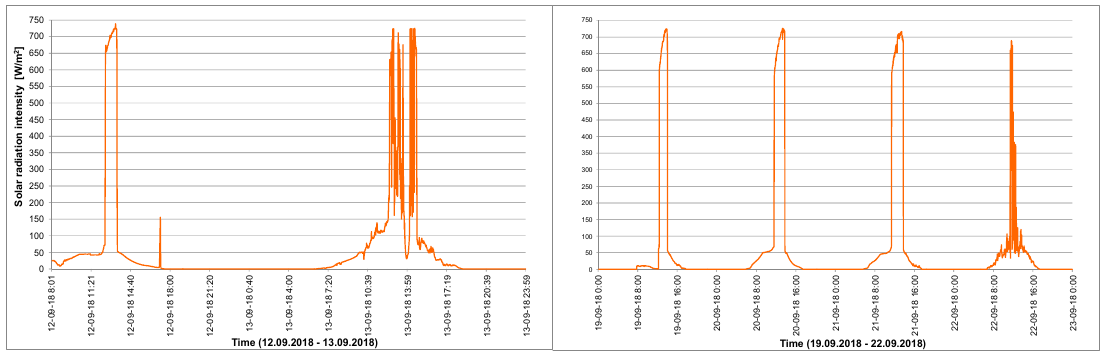
Figure 5. Distribution of average wind speed obtained on the basis of measurements carried out in the period from 12 September 2018 to 22 September 2018. The last series of results involved the intensity of solar radiation Figure 6.